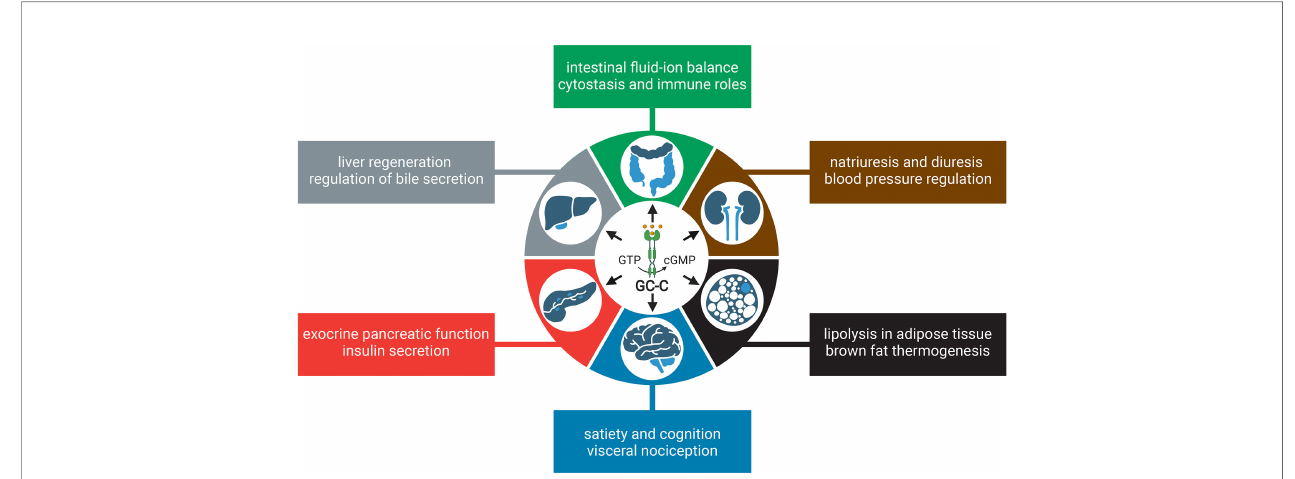
FIGURE 5 | Summary of the multiple biological functions of GC-C/cGMP signaling in health and disease. The illustration depicts the role of GC-C/cGMP signaling in the intestine and extraintestinal tissues, with key functions highlighted. The fi gure was prepared using